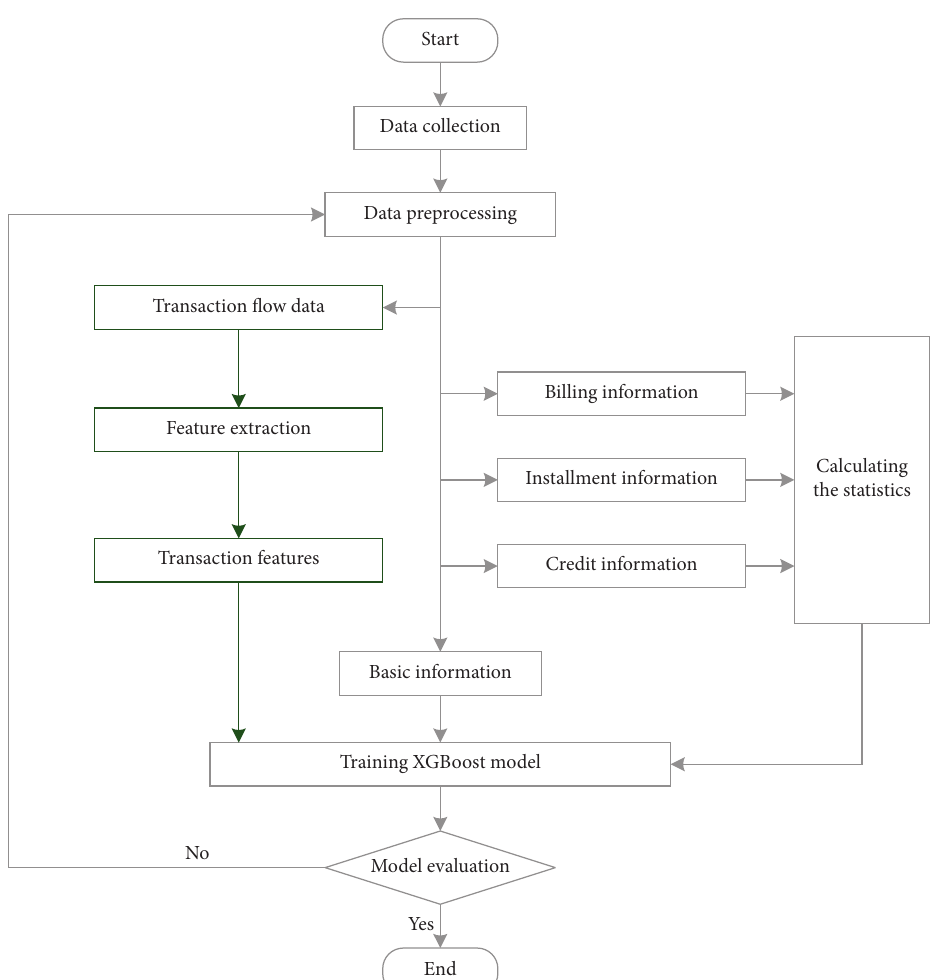
Figure 1: The flow chart of XGBoost model establishment.